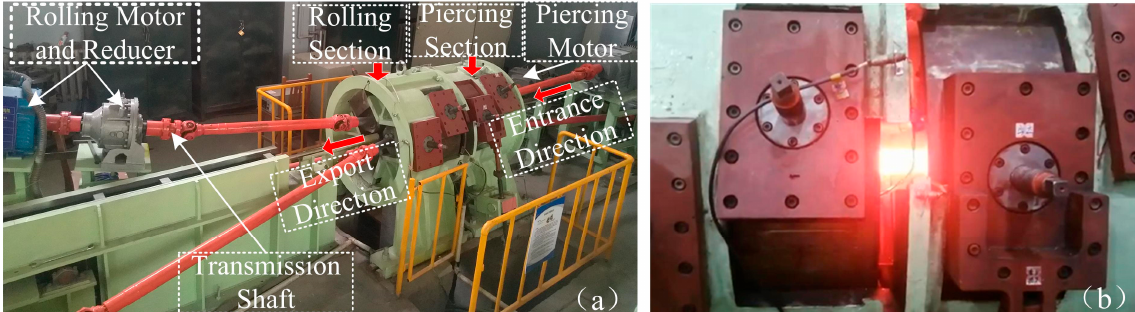
Figure 9. Field experiment: ( a ) the TSR mill; ( b ) the experiment process.